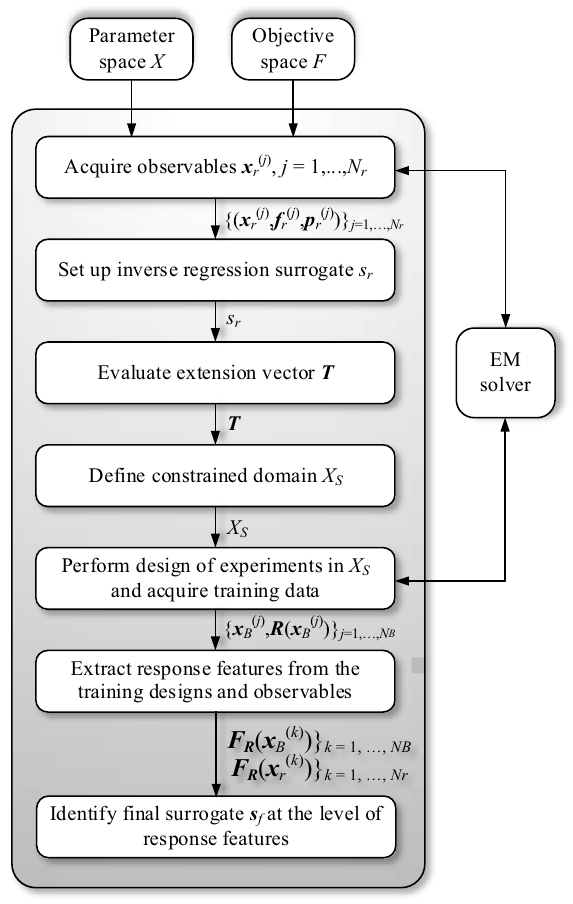
Figure 3. Flow diagram of the feature-based reference-design-free constrained modeling